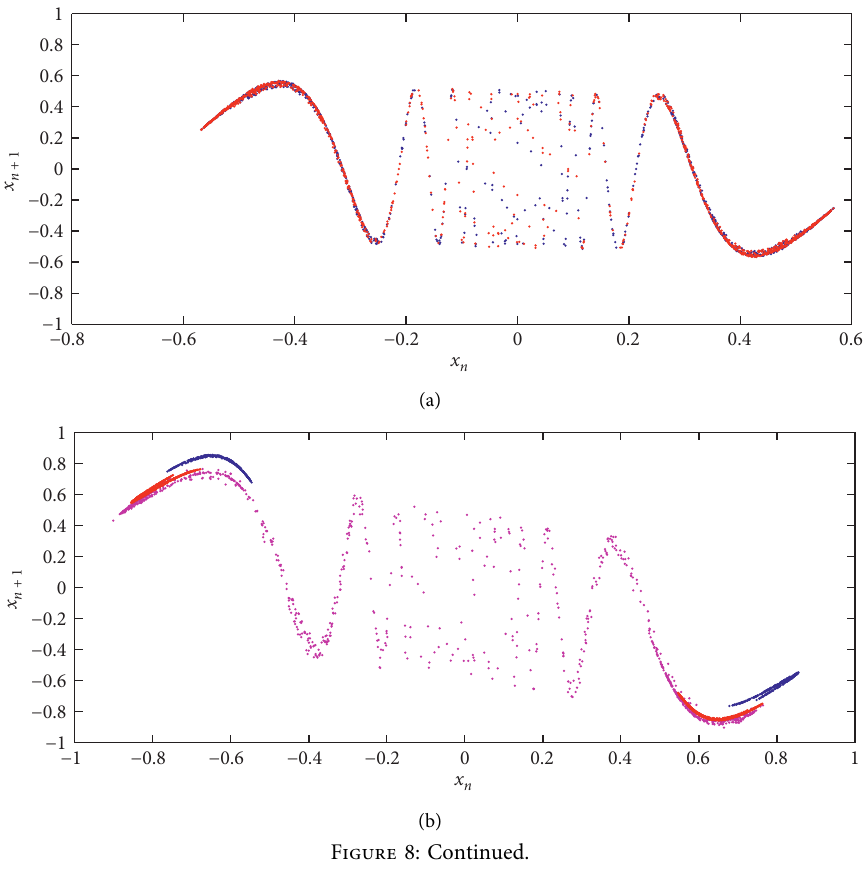
� 0 . 1 for the blue diagram and x � − 0 . 1 for the red 0 0